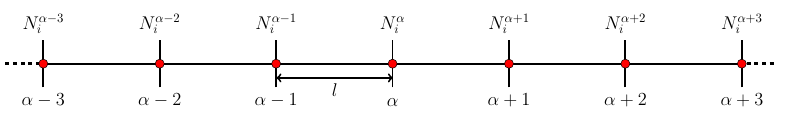
Figure 3. Schematic diagram of two volume elements of a 1D space discretization used to calculate spatial gradients within the stochastic cluster dynamics method (SCD). The superindex α refers to the physical element, while the subindex i refers to the cluster